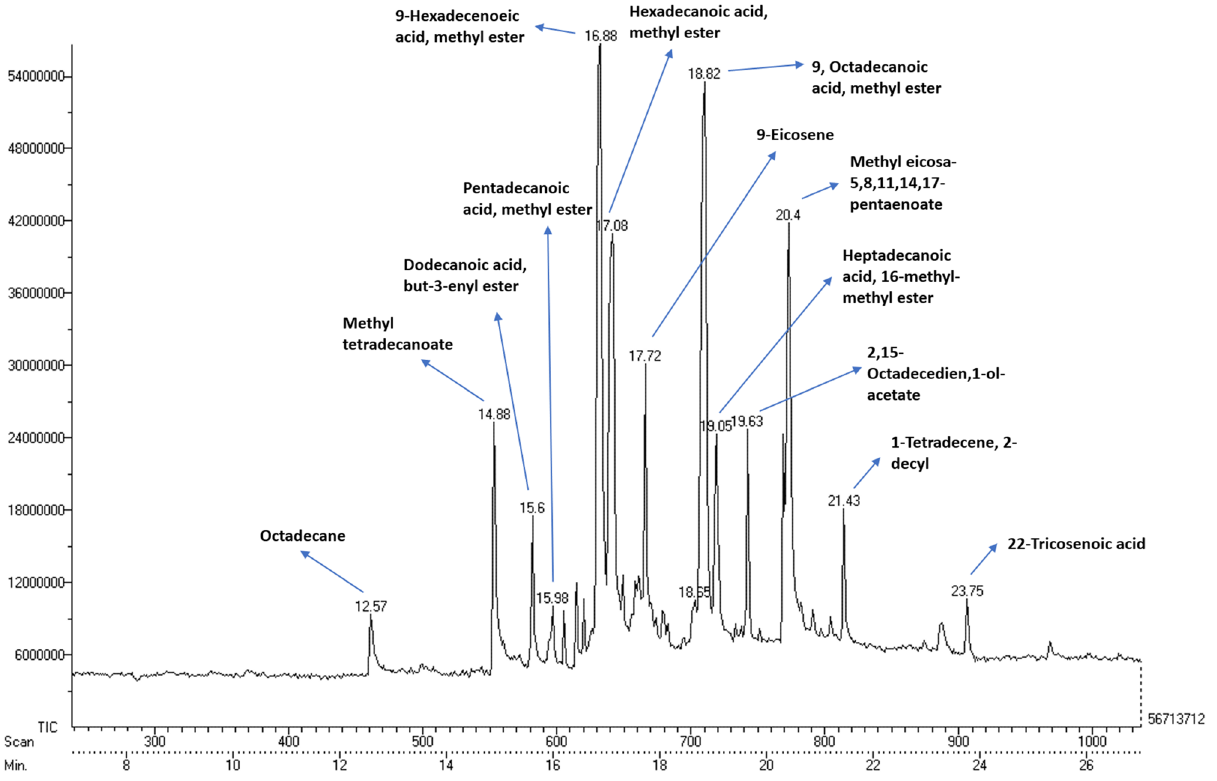
Figure 13. Gas chromatography spectrum of control sample (without LDPE sheet).